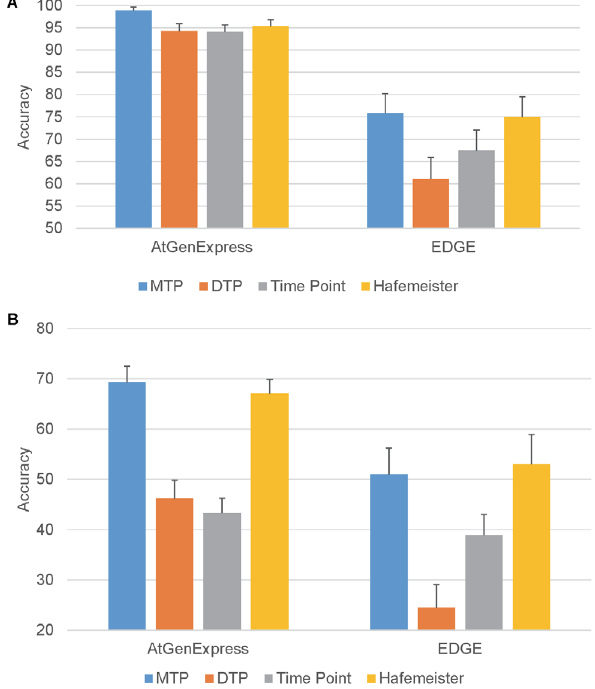
Figure 3. Accuracy of cross-validations using different param- eters. A) Accuracy computed under scenario 1 (see Methods). B) Accuracy computed under scenario 2 (see Methods). Error bars indicate 1 standard deviation away from the mean.